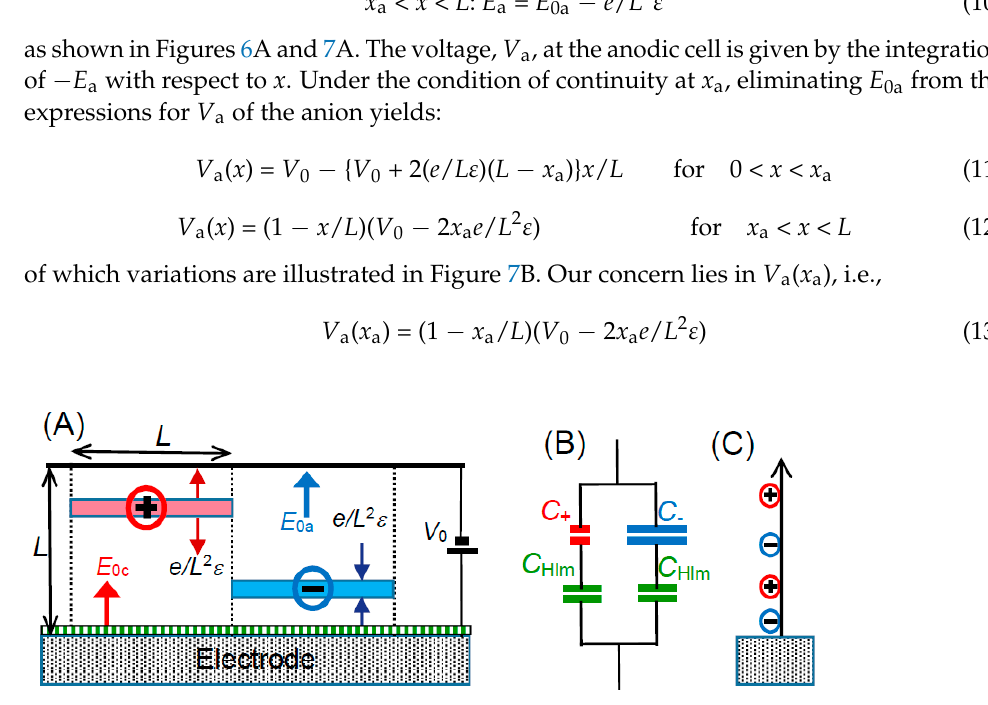
Figure 7. Profiles of ( A ) the electric fields and ( B ) the voltages along the axis (x) perpendicular to the electrode, where x a and x c are location of an anion and a cation. We determine x a by balance of the electric energy eV a ( x a ) with the thermal energy with the help of the canonical ensemble. The probability of the anion at x is expressed by exp[ − ( − e ) V a ( x a )/ k B T ] for the Boltzmann constant, k B . Since values of x a can vary from 0 to L , the partition function is given by: Z a =  0 L exp( eV a ( x a )/ k B T )d x a / L =  01 exp[ Φ (1 − z )(1 − z / Λ )]d z